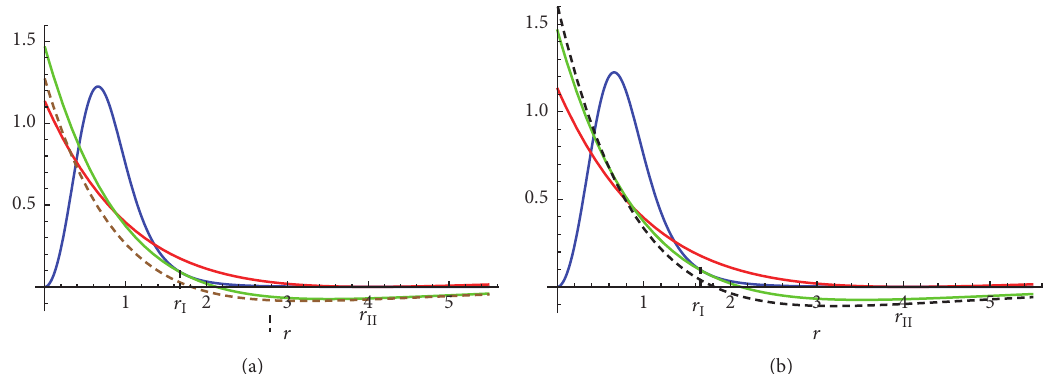
((̃𝛽/𝑏) exp tan −1 (𝑟/𝑏)) with the different ranges of